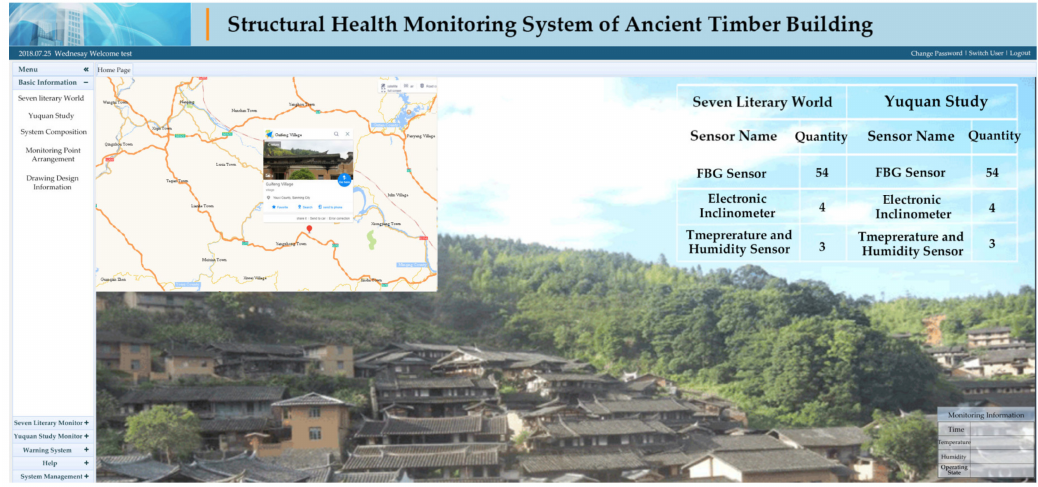
Figure 7. Structural Safety Assessment System server of the monitoring of an ancient timber